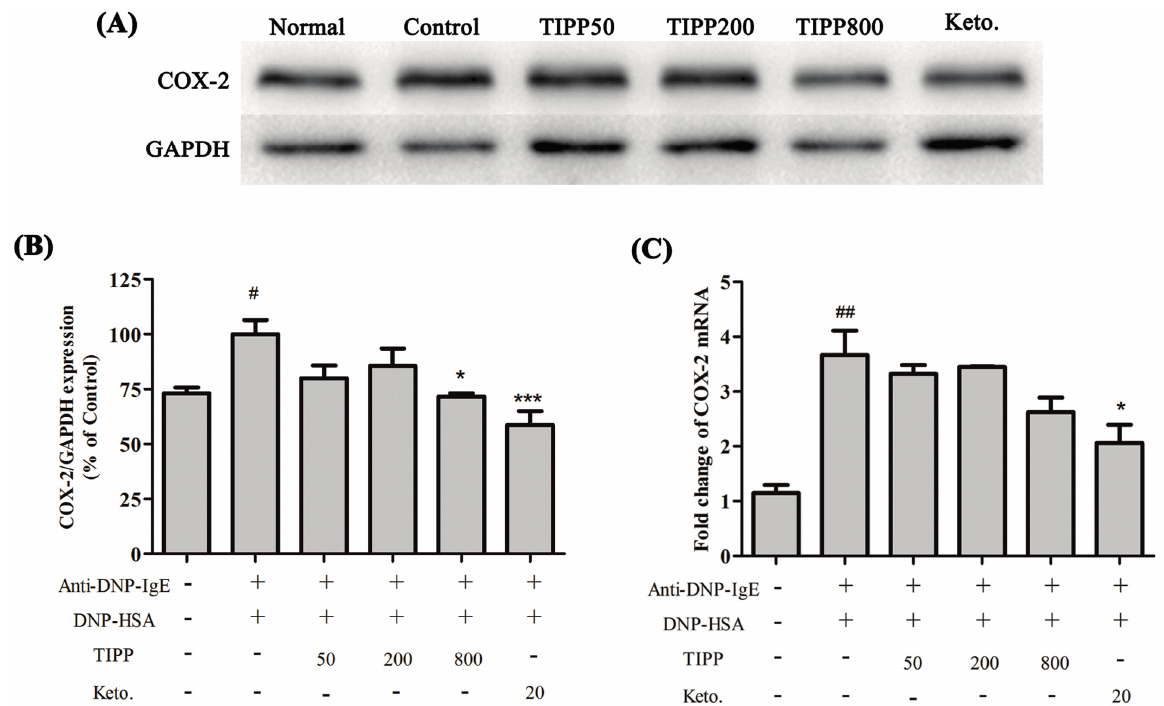
Figure 7. Western blot diagram ( A ) and statistical analysis ( B ) of COX-2 (cyclooxygenase-2) expression in IgE-antigen complex stimulated RBL-2H3 cells; ( C ) represents the statistical analysis of COX-2 mRNA levels in IgE-antigen complex stimulated RBL-2H3